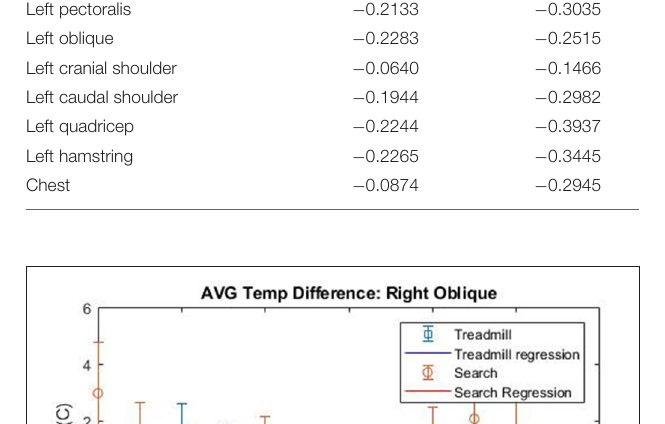
TABLE 2 | ANOVA testing for week 2 treadmill and search data, and for all data over study